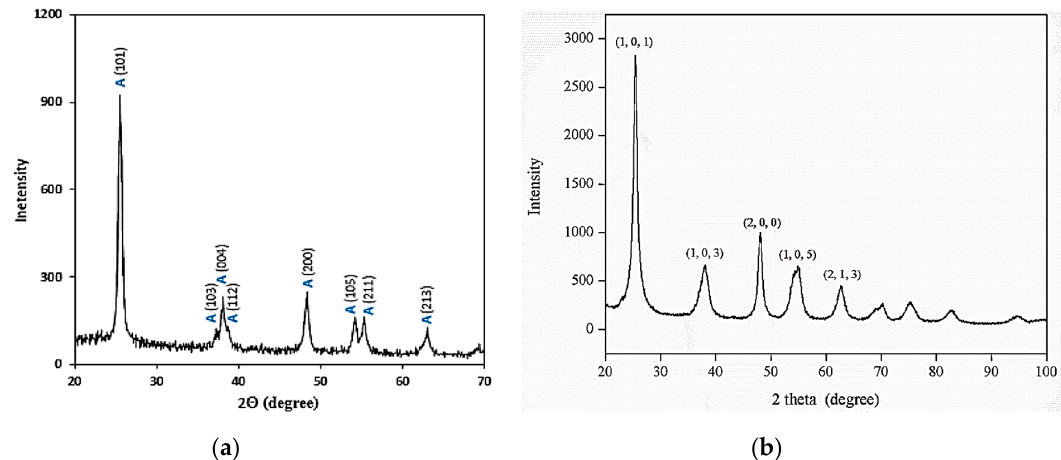
Figure 6. Comparison of the XRD patterns of the TiO 2 nanoparticles from ( a ) Al-Taweel and Saud et al. [53] and ( b ) the current study. Figure 6a is reproduced with permission from [Al-Taweel, S.S.; Saud, H.R. New route for synthesis of pure anatase TiO 2 nanoparticles via ultrasound assisted sol-gel method, Published by ( J. Chem. Pharm. Res. ) 2016].